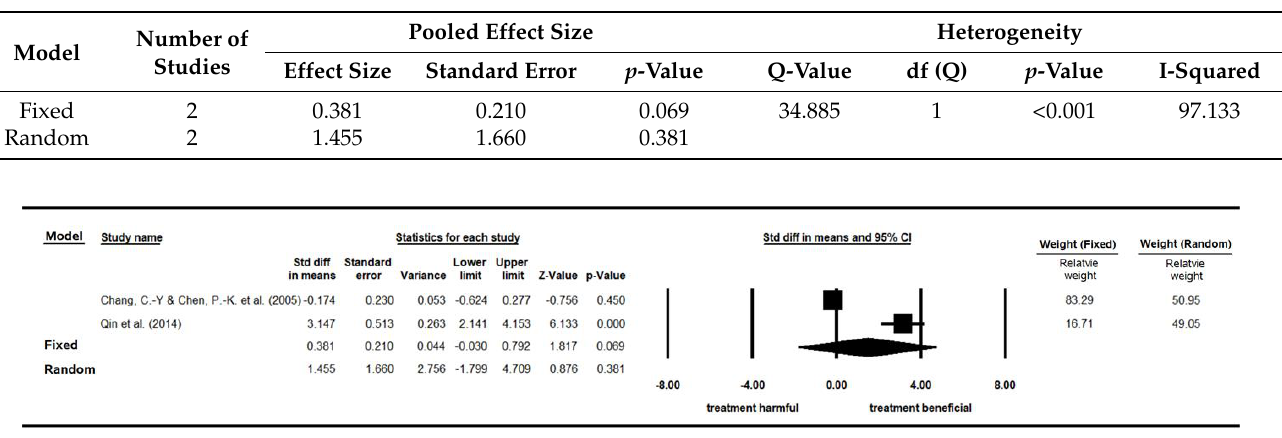
Table 13. Heterogeneity test results of studies on the influence of indoor plants on EEG β waves.